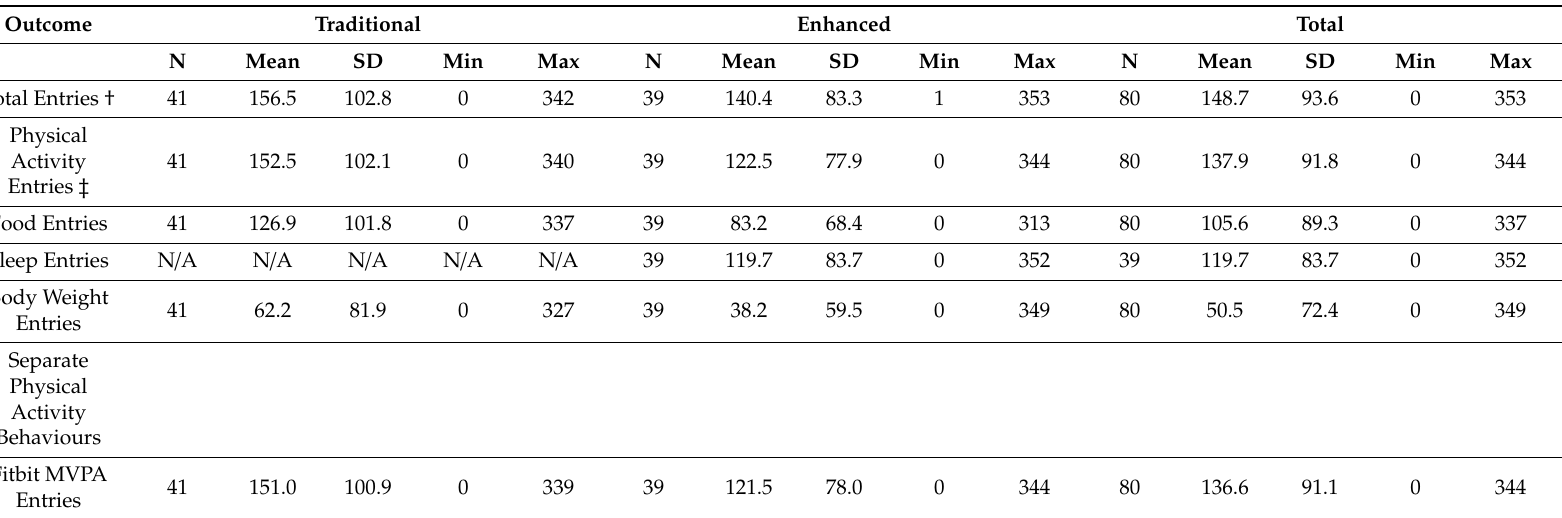
Table 4. Number of self-monitoring entries made by Move, Eat, Sleep participants using the Balanced app over 12